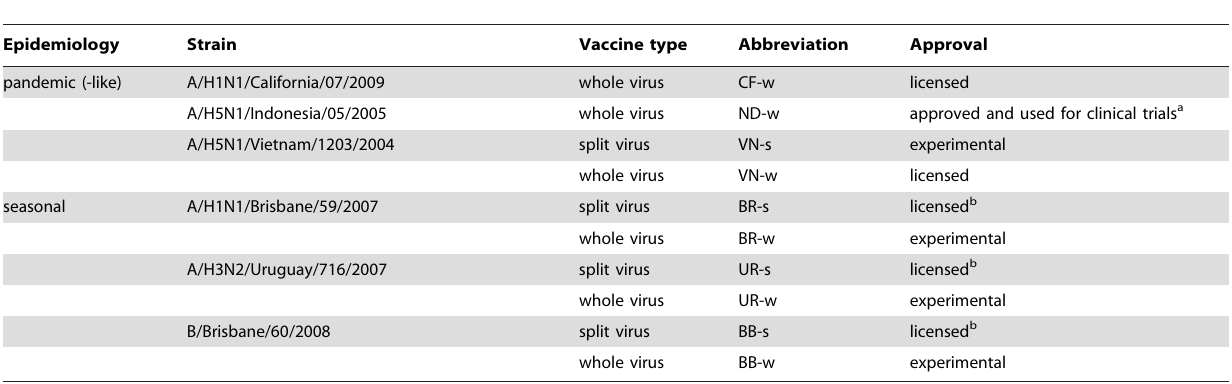
Table 1. Strain-specific influenza vaccines including type, used abbreviation, and status of regulatory